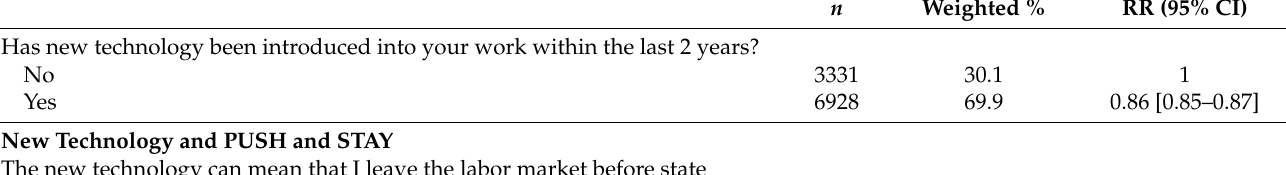
Table 2. Association between new technology at work and loss of paid employment. RR = risk ratio, CI = confidence interval.